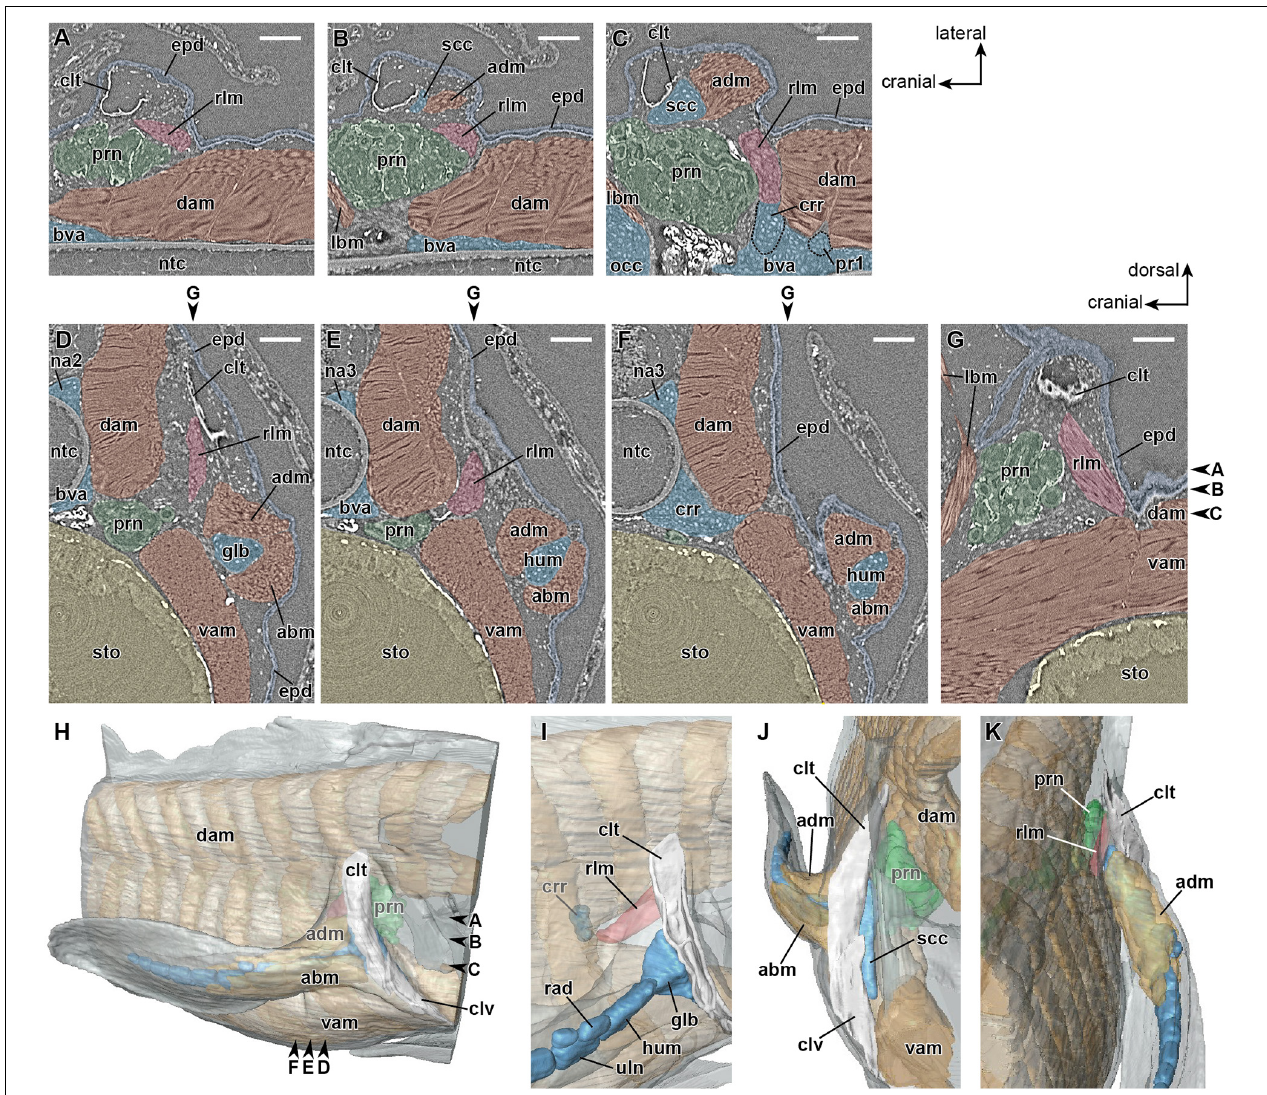
FIGURE 4 | Developing right pectoral fin of Neoceratodus forsteri at stage 48 (total length = 20.5 mm). (A–C) Coronal section. (D–F) Transverse section. (G) Sagittal section. (H) Lateral view. (I) Enlarged image of the retractor laterralis ventralis pectoralis muscle in caudolateral view. (J) Cranial view. (K) Caudal view. abm, abductor muscle; adm, adductor muscle; bva, basiventral arcualium; clt, cleithrum; clv, clavicle; dam, dorsal axial muscle; crr, cranial rib; epd, epidermis; glb, glenoid buttress of the scapulocoracoid; lbm, levator arcuum branchialium five muscle (i.e., the dorsopharyngeus muscle in Greil, 1913); hum, humerus; na2, neural arch 2; na3, neural arch 3; ntc, notochord; opc, operculum; prn, pronephros; pr1, pleural rib 1; scc, scapulocoracoid; rad, radius; rlm, retractor lateralis ventralis pectoralis muscle (i.e., the retractor cleithri muscle in Greil, 1913); sto, stomach; uln, ulna; vam, ventral axial muscle. Arrowheads indicate the respective sectioned levels. Scale bar = 200 µ